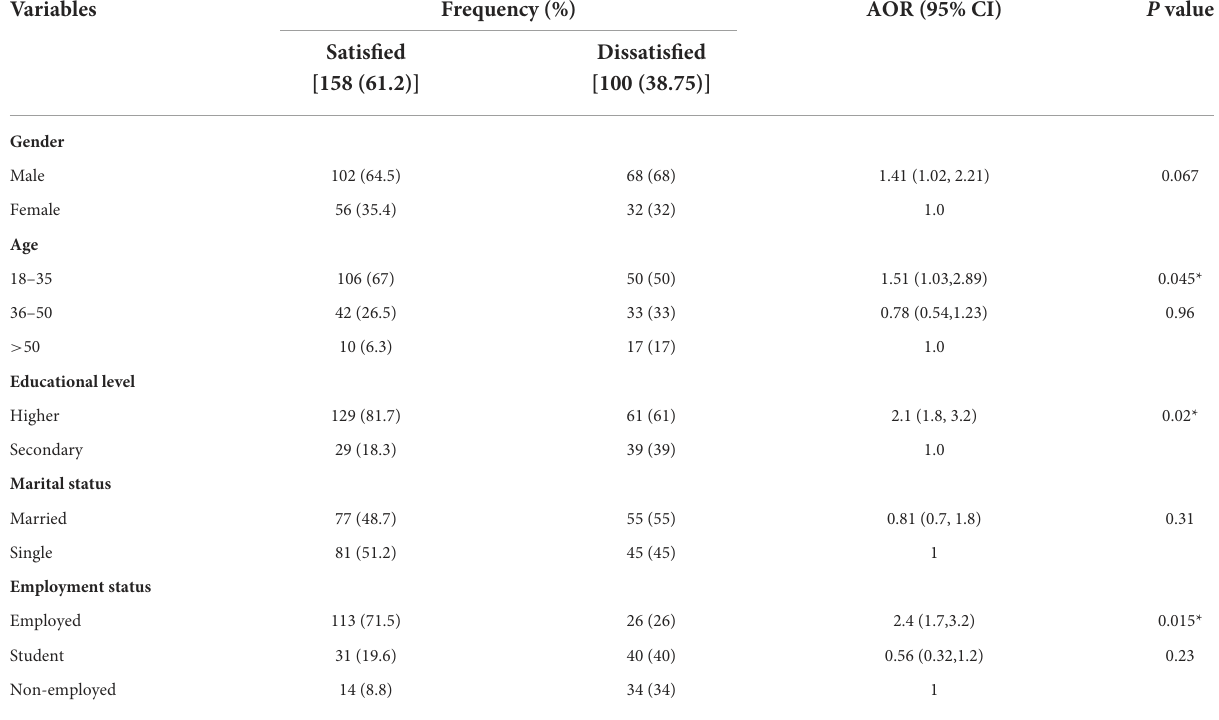
TABLE 7 Bivariate and multivariable logistic regression analysis of factors influencing patients’ satisfaction on PSQ-18 items